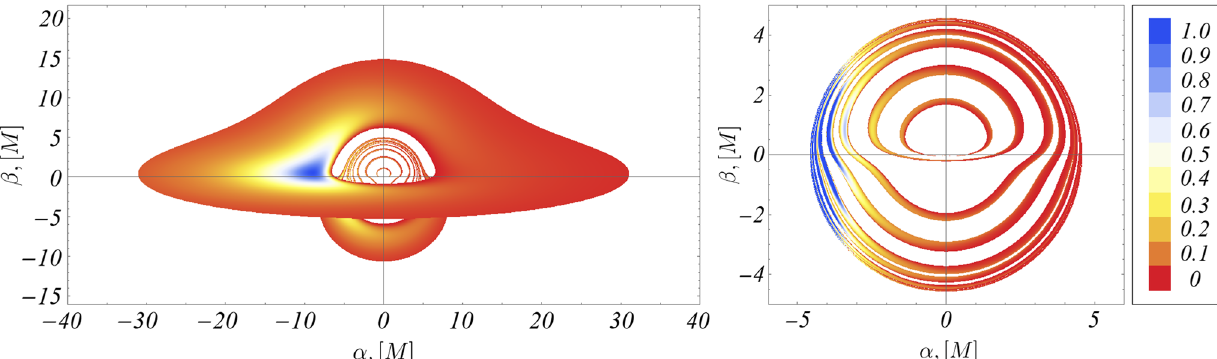
Fig. 3 Apparent radiation flux for the Gauss–Bonnet weakly naked singularity with ˆ γ = 1 . 15. The radiation from the outer disk (left) and the inner disk (right) are represented separately in order to make the image more transparent. The maximum of the observable radiation